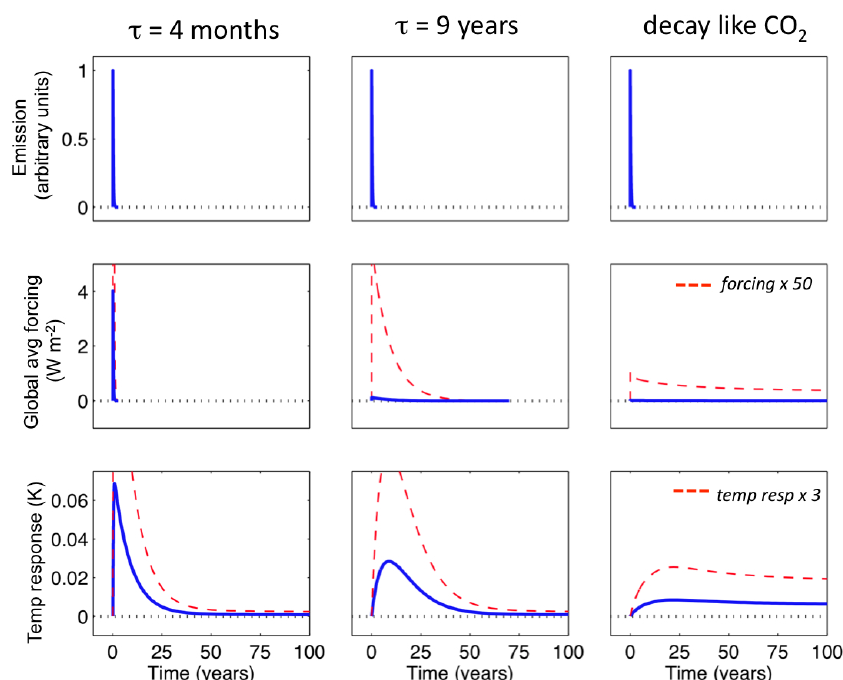
Fig. 1. Forcing and response to pulse emissions of hypothetical substances with different atmospheric lifetimes. Each trace is discontinued when the signal drops below 10 − 5 of the peak value of the short-lived forcer. Forcing (middle panels) has been scaled so that the area under each of three curves is identical over 100 years. Dashed red trace shows forcing value times 50 to show more detail in the time dependence. Temperature response (lower panels) is estimated with the relationship and parameters given by Boucher and Reddy (2007), and assumes that spatial dependence of forcing is similar to that of CO 2